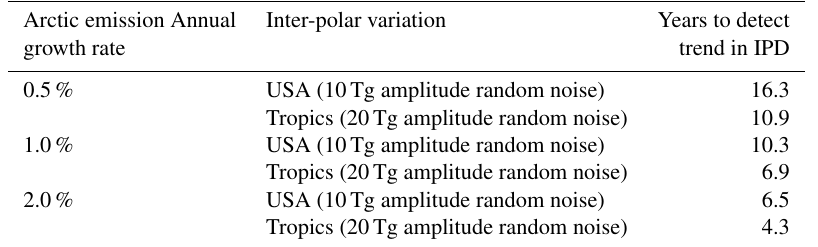
Table 2. Number of years required to detect a statistically significant trend in Arctic emissions in the presence of inter-polar emission